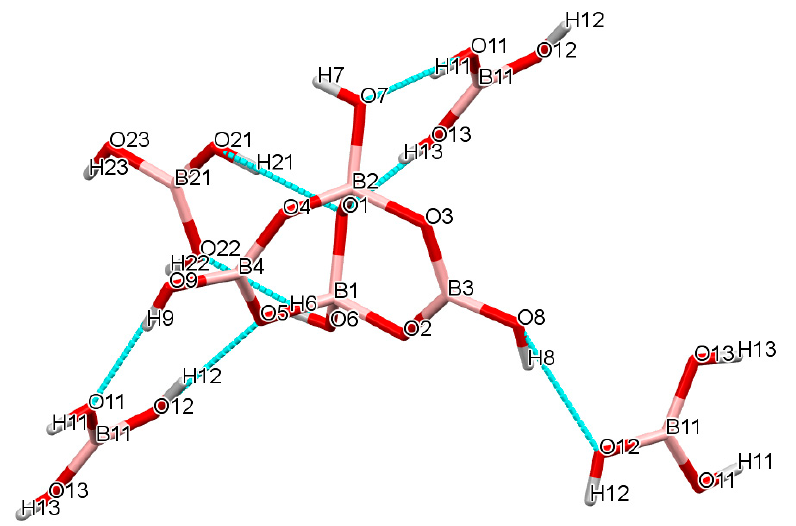
Figure 7. Drawing of the H-bond interactions around the tetraborate(2-) anion in 9 , showing three R 22 (8) interactions and parts of the C 22 (8) chain.